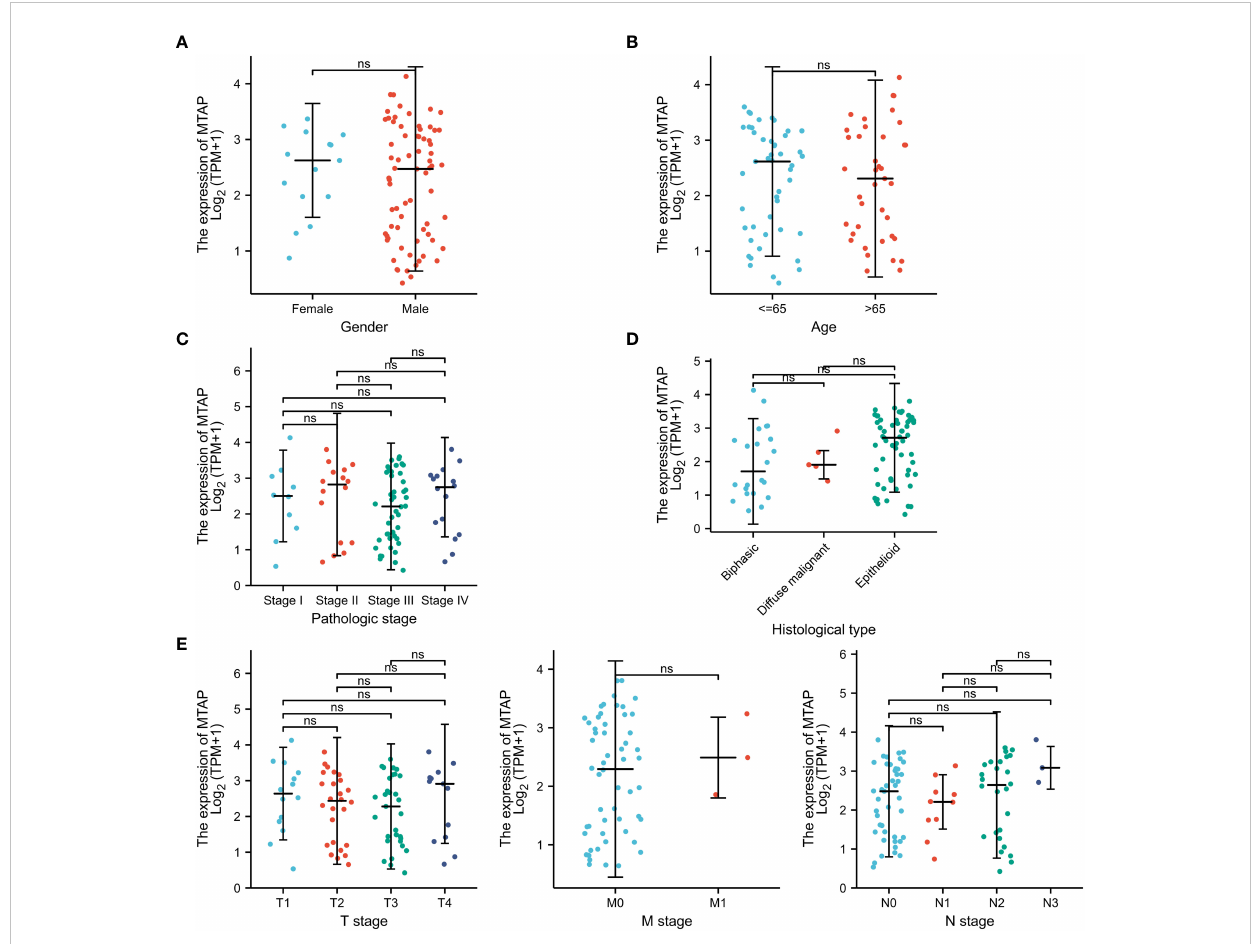
FIGURE 7 Subgroup differences of MTAP gene expression in mesothelioma. ns, not signi fi